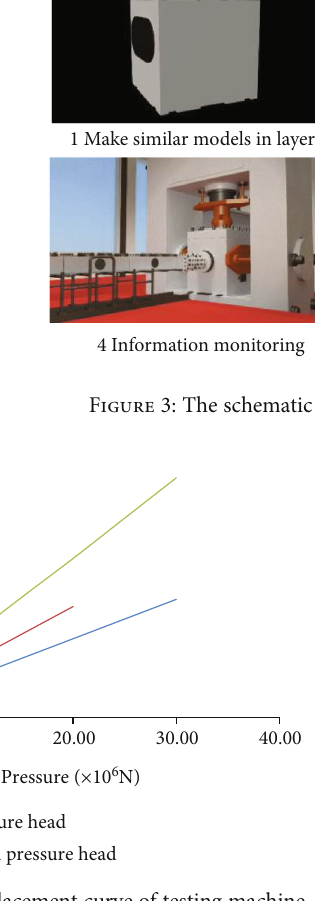
Figure 4: Indenter displacement curve of testing machine.